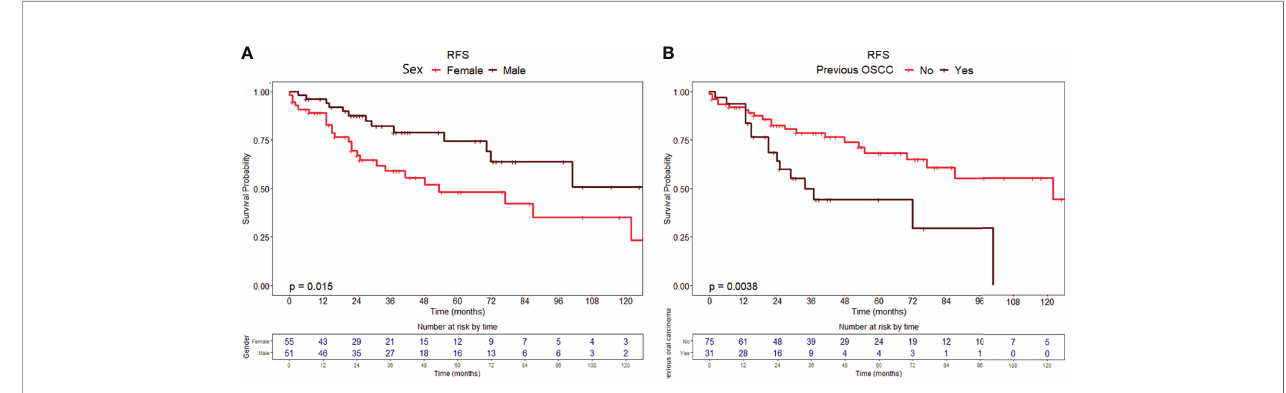
FIGURE 2 | Recurrence-free survival curves with relative tables of patients at risk according to (A) sex and (B) history of previous OSCC.